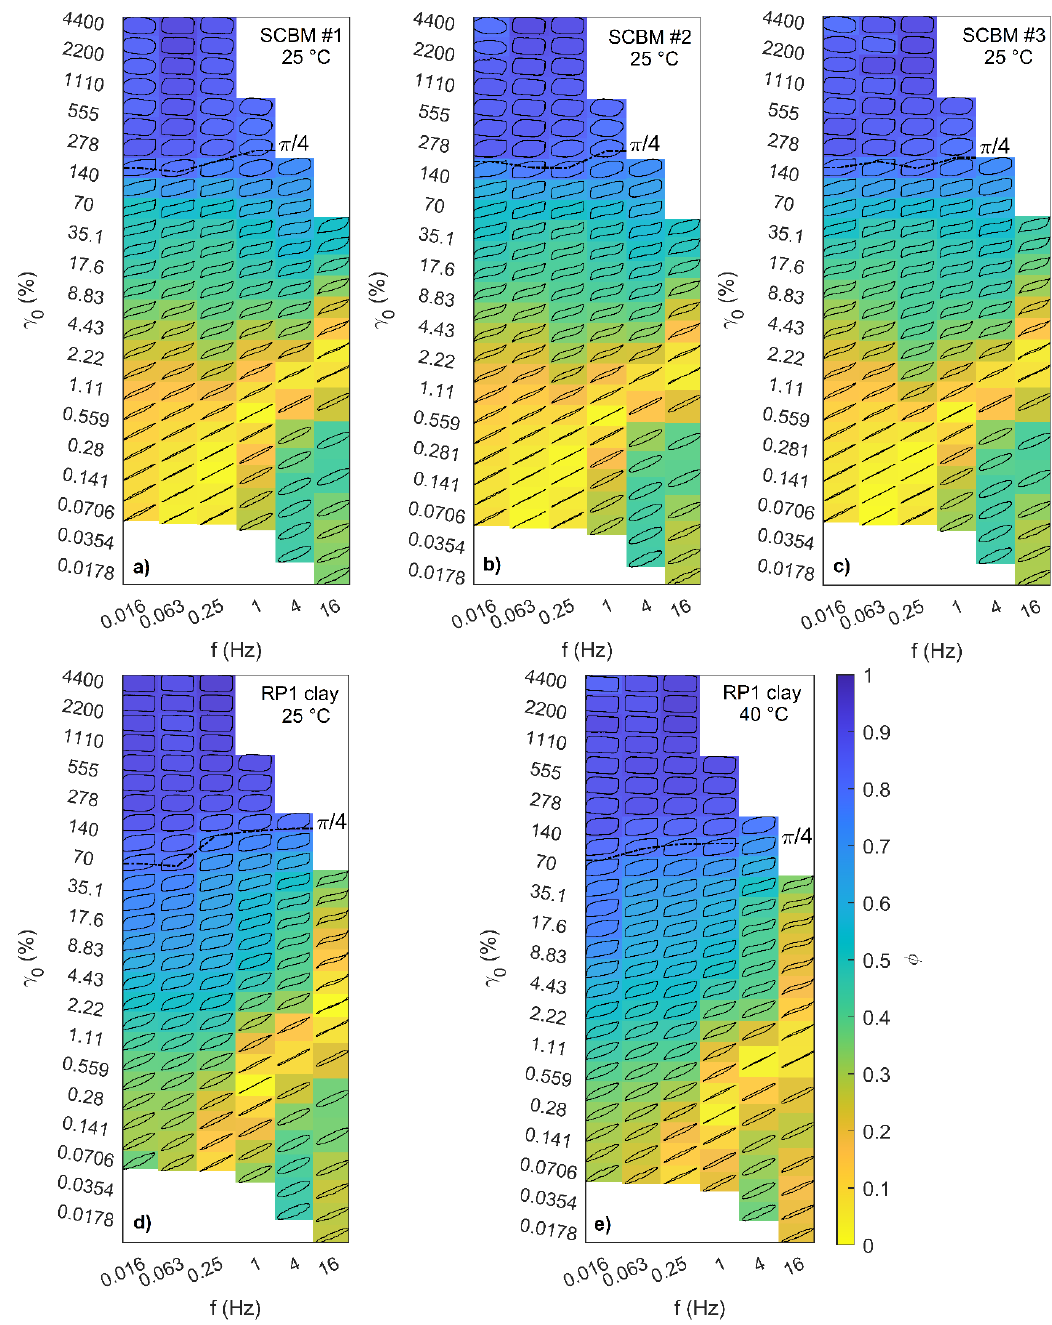
Figure 4. Tenth cycle of raw LAOS data for ( a ) SCBM #1, ( b ) SCBM #2, ( c ) SCBM #3, ( d ) RP1 clay measured at 25 °C, and ( e ) RP1 clay measured at 40 °C, shown as elastic Lissajous−Bowditch loops of normalized stress versus normalized strain ( σ ( t )⁄ σ max vs. γ ( t )⁄ γ 0 ) within the Pipkin space of frequency and strain amplitude. The color filled within each Lissajous loop corresponds to the value of the dissipation ratio ϕ in the color bar of (e). The dashed line represents ϕ = π /4. View in color for best